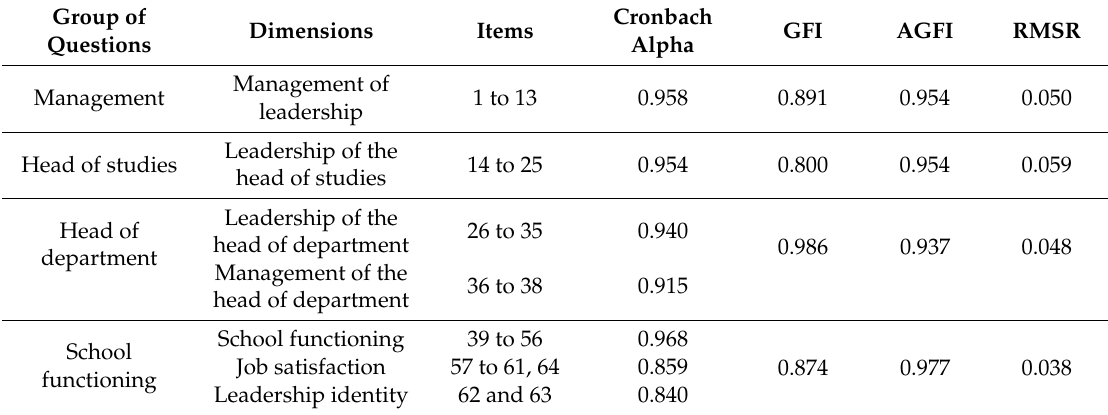
Table 1. Dimensions of the questionnaire—reliability and model